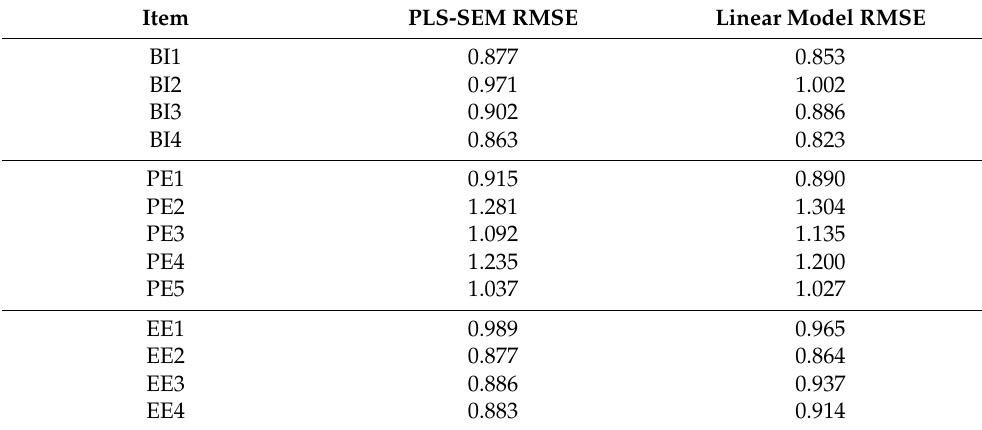
Table 3. PLSpredict RMSE results of the UTAUT